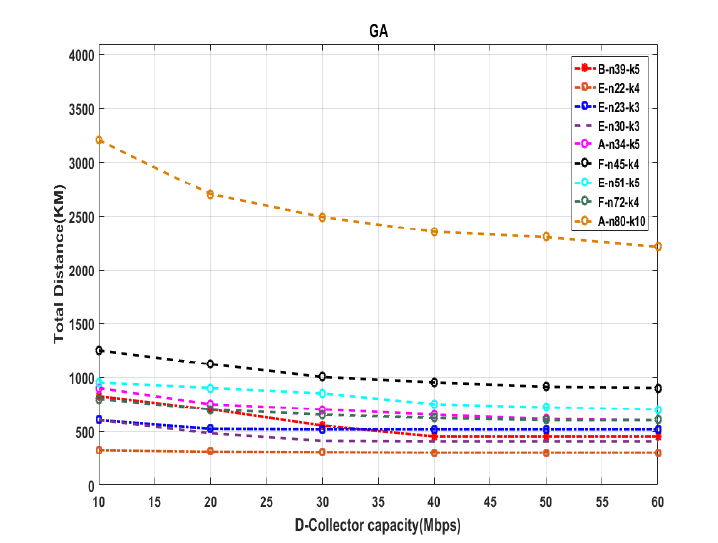
Figure 10. D-collector capacity vs. total distance (GA).